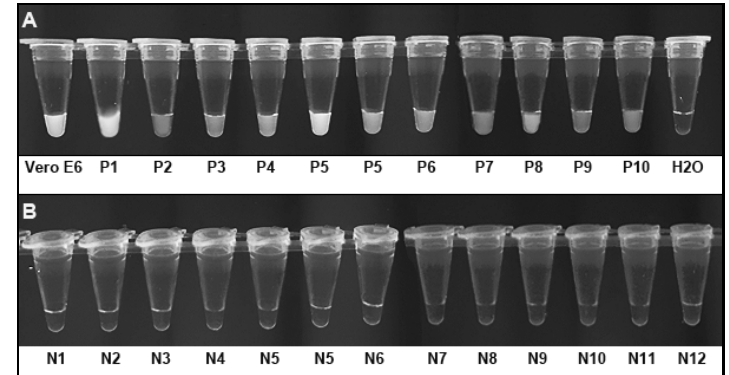
Figure 7. CRISPR-Cas12a could directly test clinical specimens for SARS-CoV-2. Five µ L of each clinical sample was heated at 65 ◦ C for 30 min and subjected to RT-RPA without RNA extraction, and then underwent CRISPR-Cas12a reaction. The results were directly visualized by imaging the tubes. ( A ) Ten SARS-CoV-2-positive nasopharyngeal swabs had the evidence of SARS-CoV-2 as demonstrated by bright fluorescence signals. The supernatant of Vero E6 cells infected with SARS- CoV-2 was positive, while H 2 O was negative for SARS-CoV-2. ( B ) The nasopharyngeal swabs from 12 control individuals displayed negative results as demonstrated by the lack of fluorescence signal. Vero E6, Vero E6 cells infected with SARS-CoV-2; P, positive nasopharyngeal swabs for SARS-CoV-2; N, negative nasopharyngeal swabs for